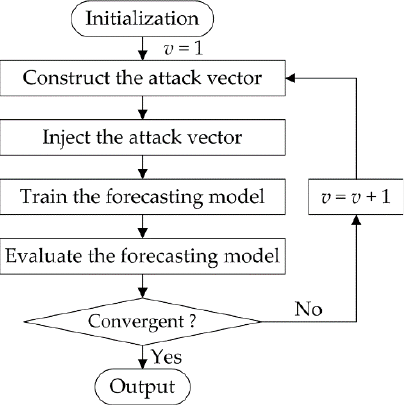
Figure 3. Flow chart of the proposed robustness assessment for wind power forecasting.